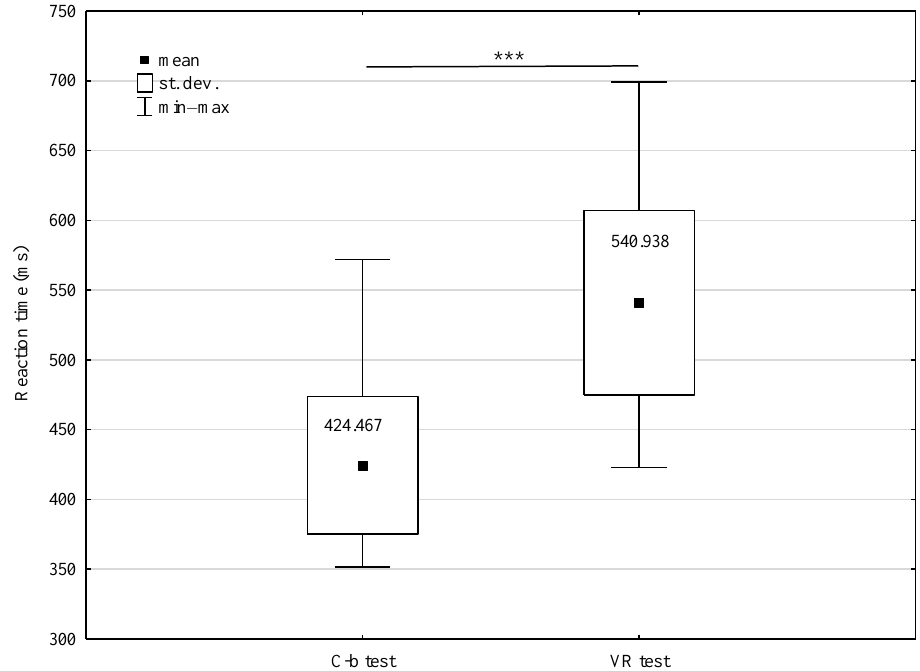
Figure 10. Complex RT of MMA fighters during the tests in VR and computer-based (C-b) tests, *** p < 0.001.